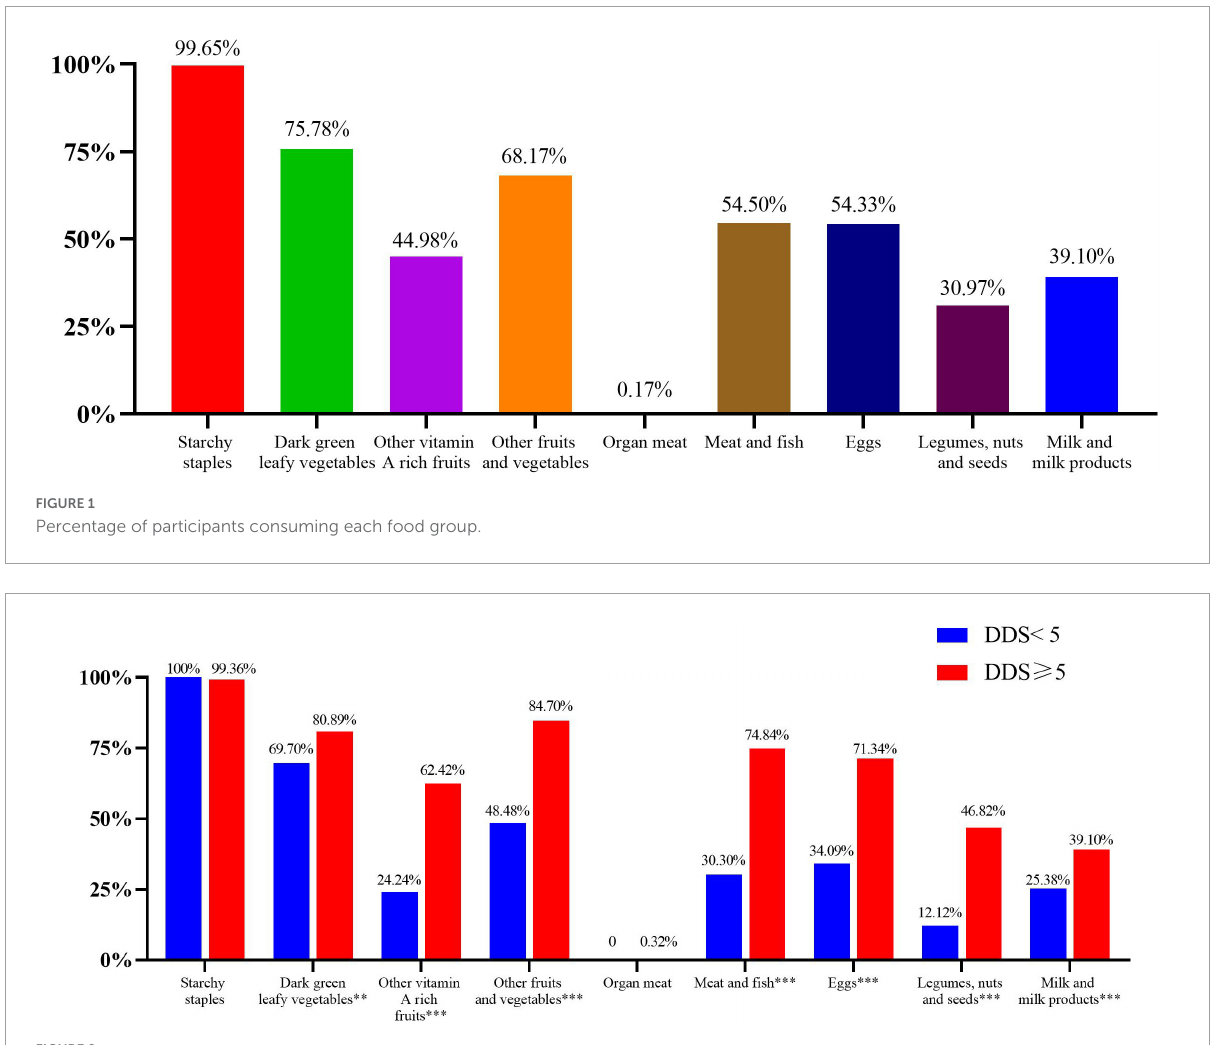
FIGURE2 Percentage of participants consuming each food group in low and high DDS groups. ** p < 0.01, *** p <